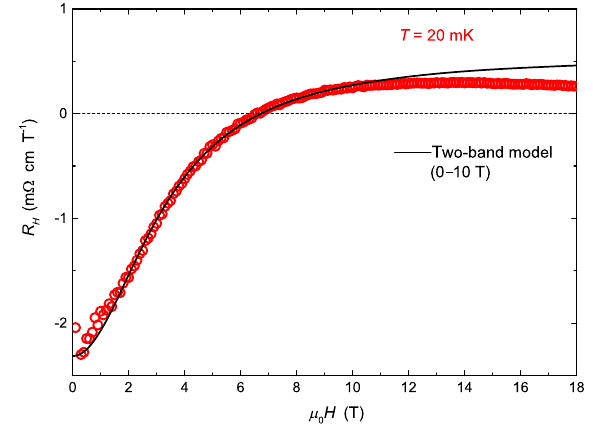
FIG. 11. Fitting of the field dependence of the Hall coefficient R H Þ below 10 T using a two-band model with the constraint H ð from the zero-field resistivity [Eq. (A4) in Appendix C]. R is measured in sample N 2 at T ¼ 20